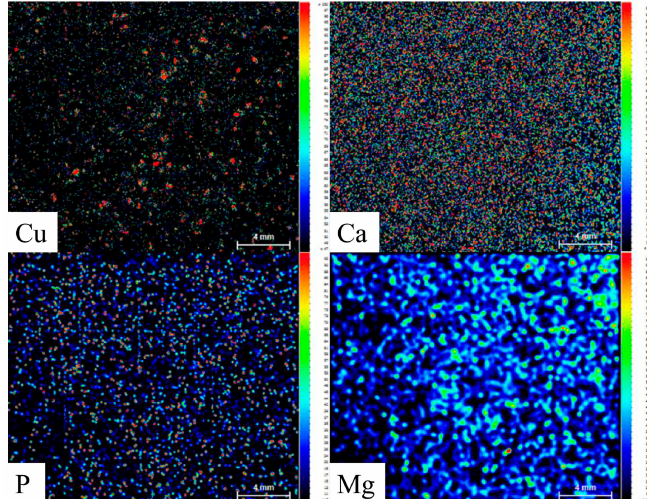
Figure 14. Distribution of Cu, Ca, P, Mg in SASs after application of BR for five seasons under the